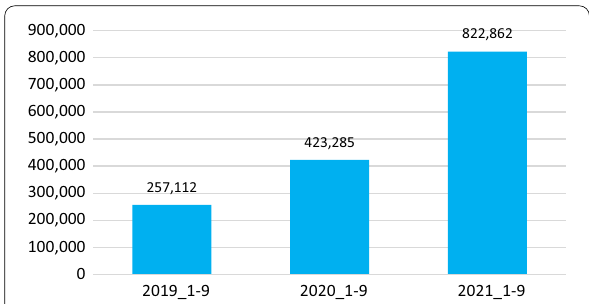
Fig. 3 Number of accesses* in the first 9 months of 2019, 2020, and 2021 (Source: